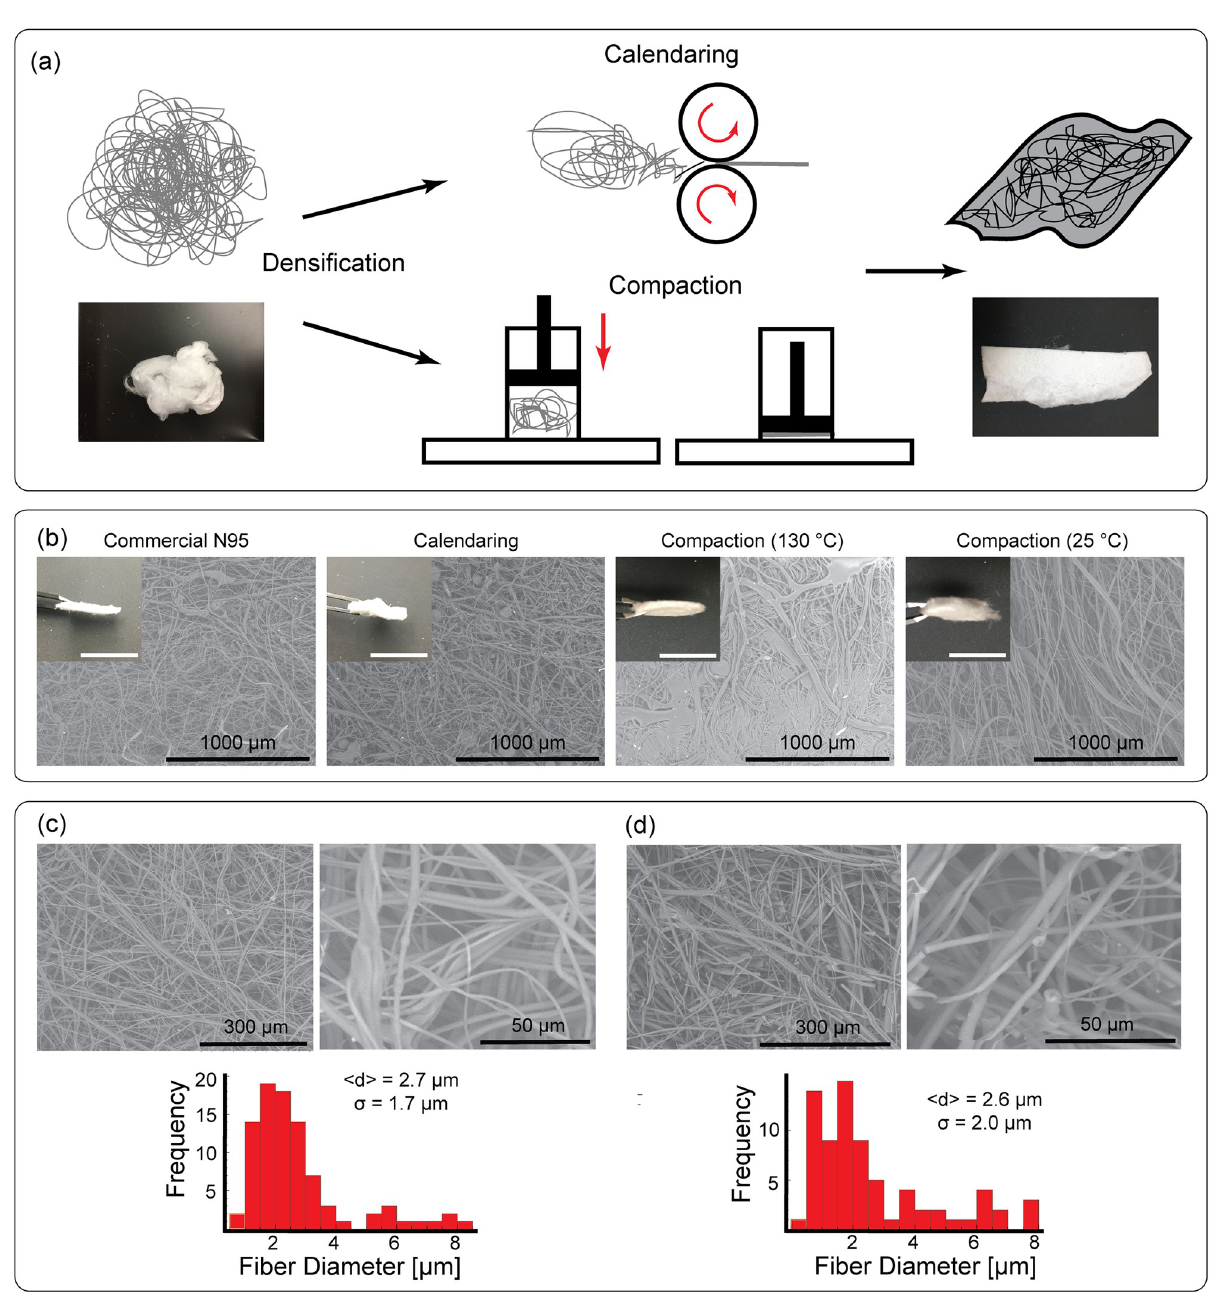
Fig 2. Fiber processing and characterization. A: Produced fibers must be processed into dense mats before they can be used as a filtration media. We evaluate two methods: i) calendaring and ii) compaction. Photographs show as-produced material (left) and material after compaction (right). B: SEM characterization of large-scale features of non-woven filtration media produced using Pinnacle 1112 PP homopolymer (MFI = 12 g/10 min). Insets show a macroscopic section of material obtained after each densification process compared with material obtained from a commercial N95 mask; scale bar represents to 1 cm. C: SEM characterization (top) enables comparison of fiber morphology between commercial N95 and fibers produced from using a modified CCM (image obtained from calendared sample shown in part B). Histograms (bottom) of fiber diameters show that both samples share a similar long-tailed distribution of fiber diameters. The black curve is a continuous probability distribution derived from the experimental data. Insets show the same distribution plotted on a logarithmic axis. Fiber diameters were measured from the sample at several different locations using 150 fiber